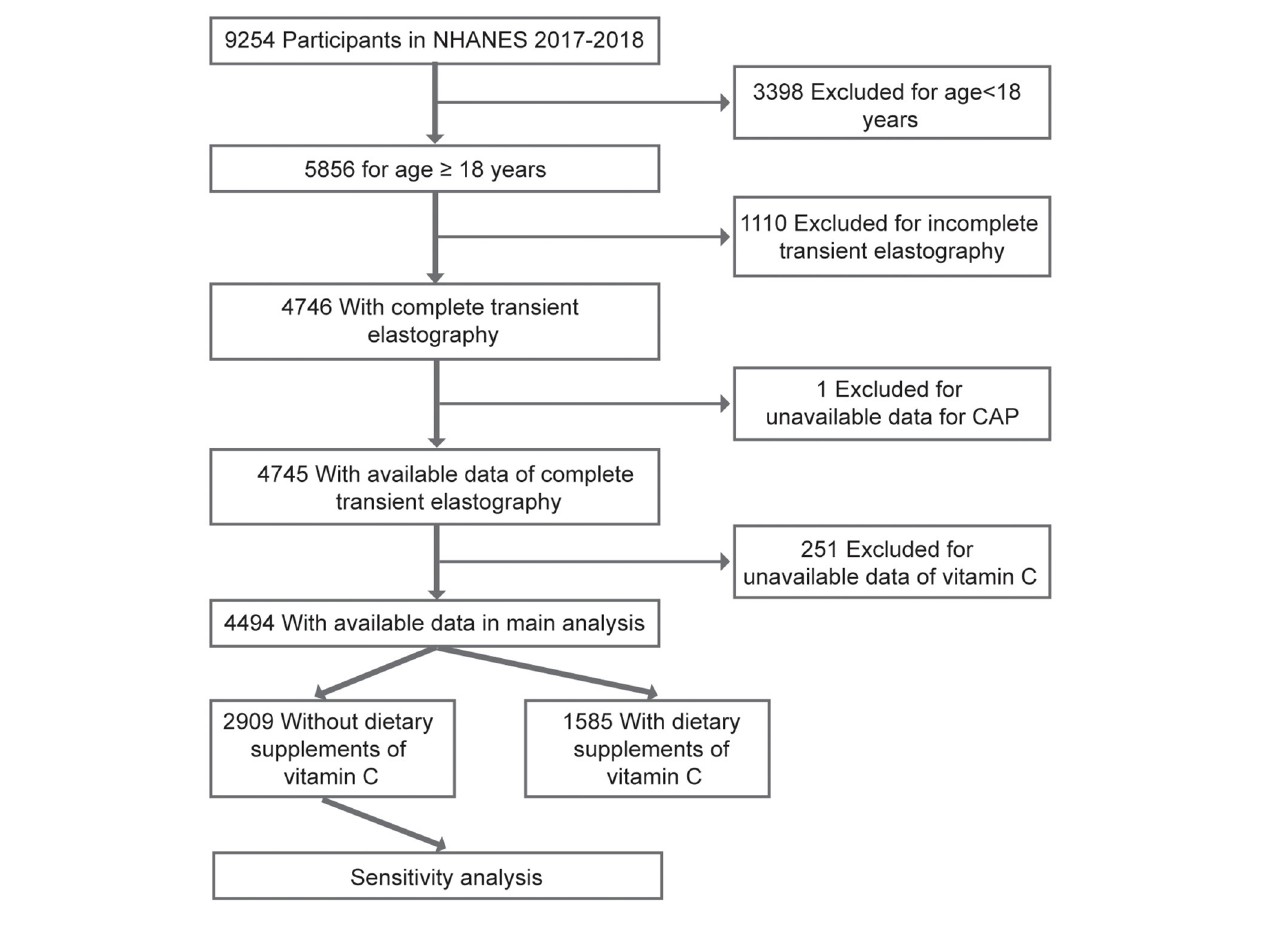
FIGURE 1 | A flowchart showing the selection of study participants. CAP, controlled attenuation